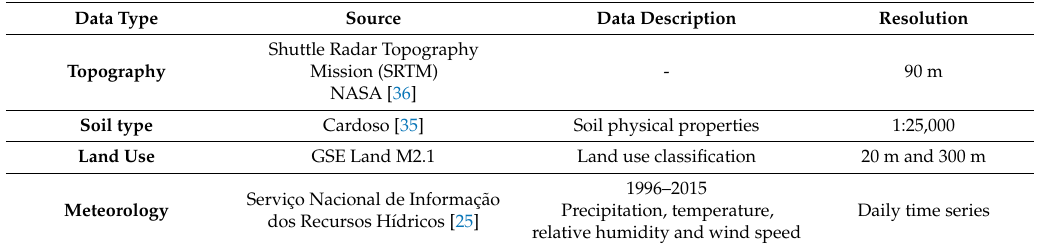
Table 1. The input data used in the Soil Water Assessment Tool (SWAT) model application.